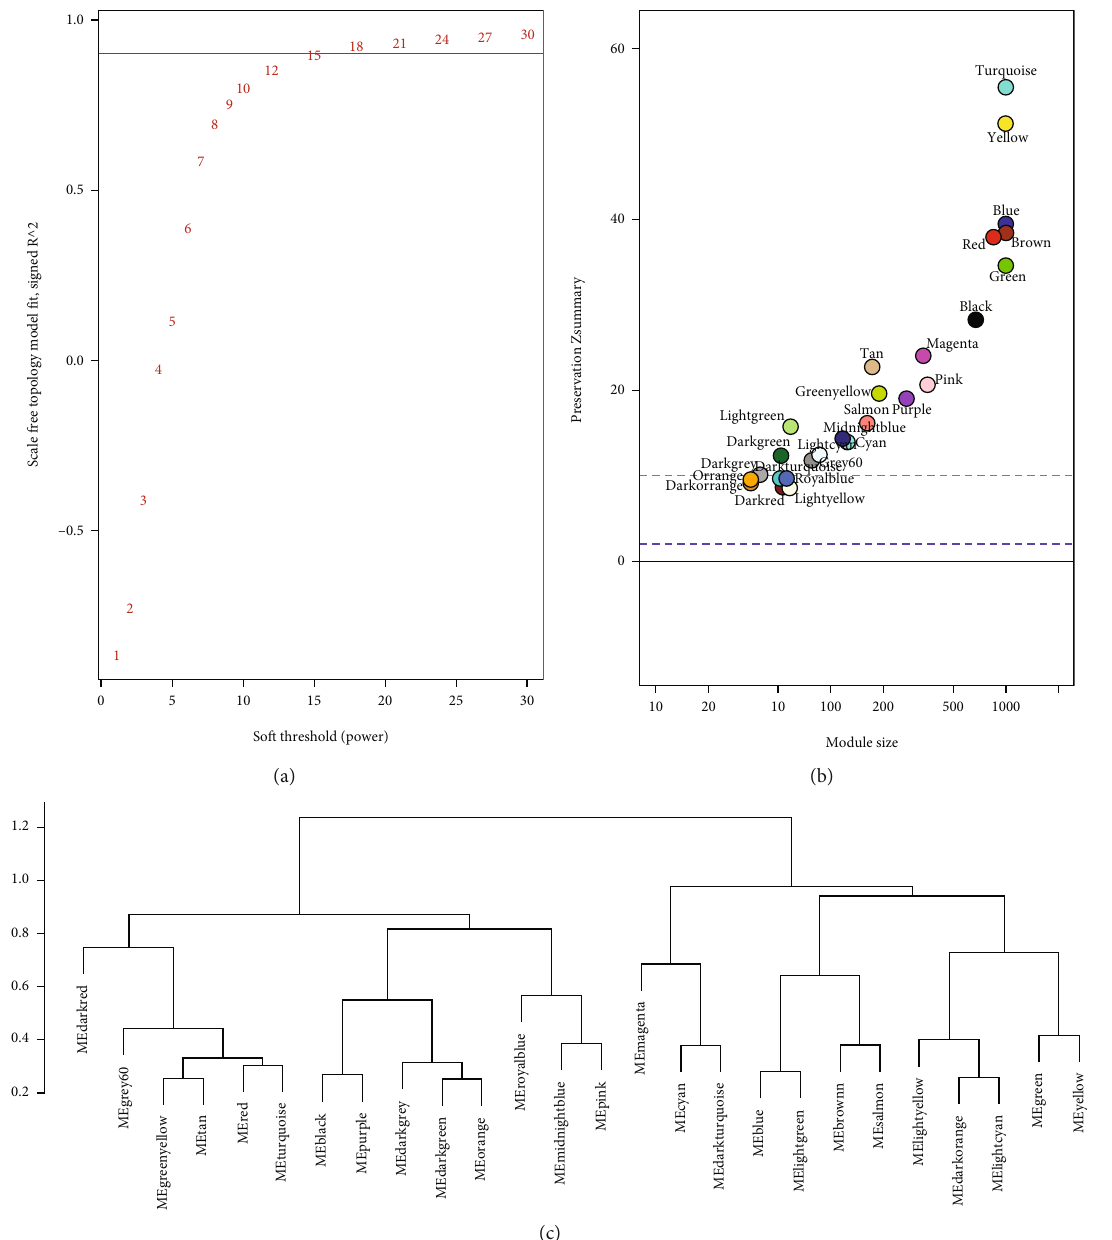
Figure 3: Construction of the draft GCN for SE. (a) Network topology for di ff erent soft-thresholding powers. (b) Module preservation statistics. (c) Hierarchical clustering dendrogram of